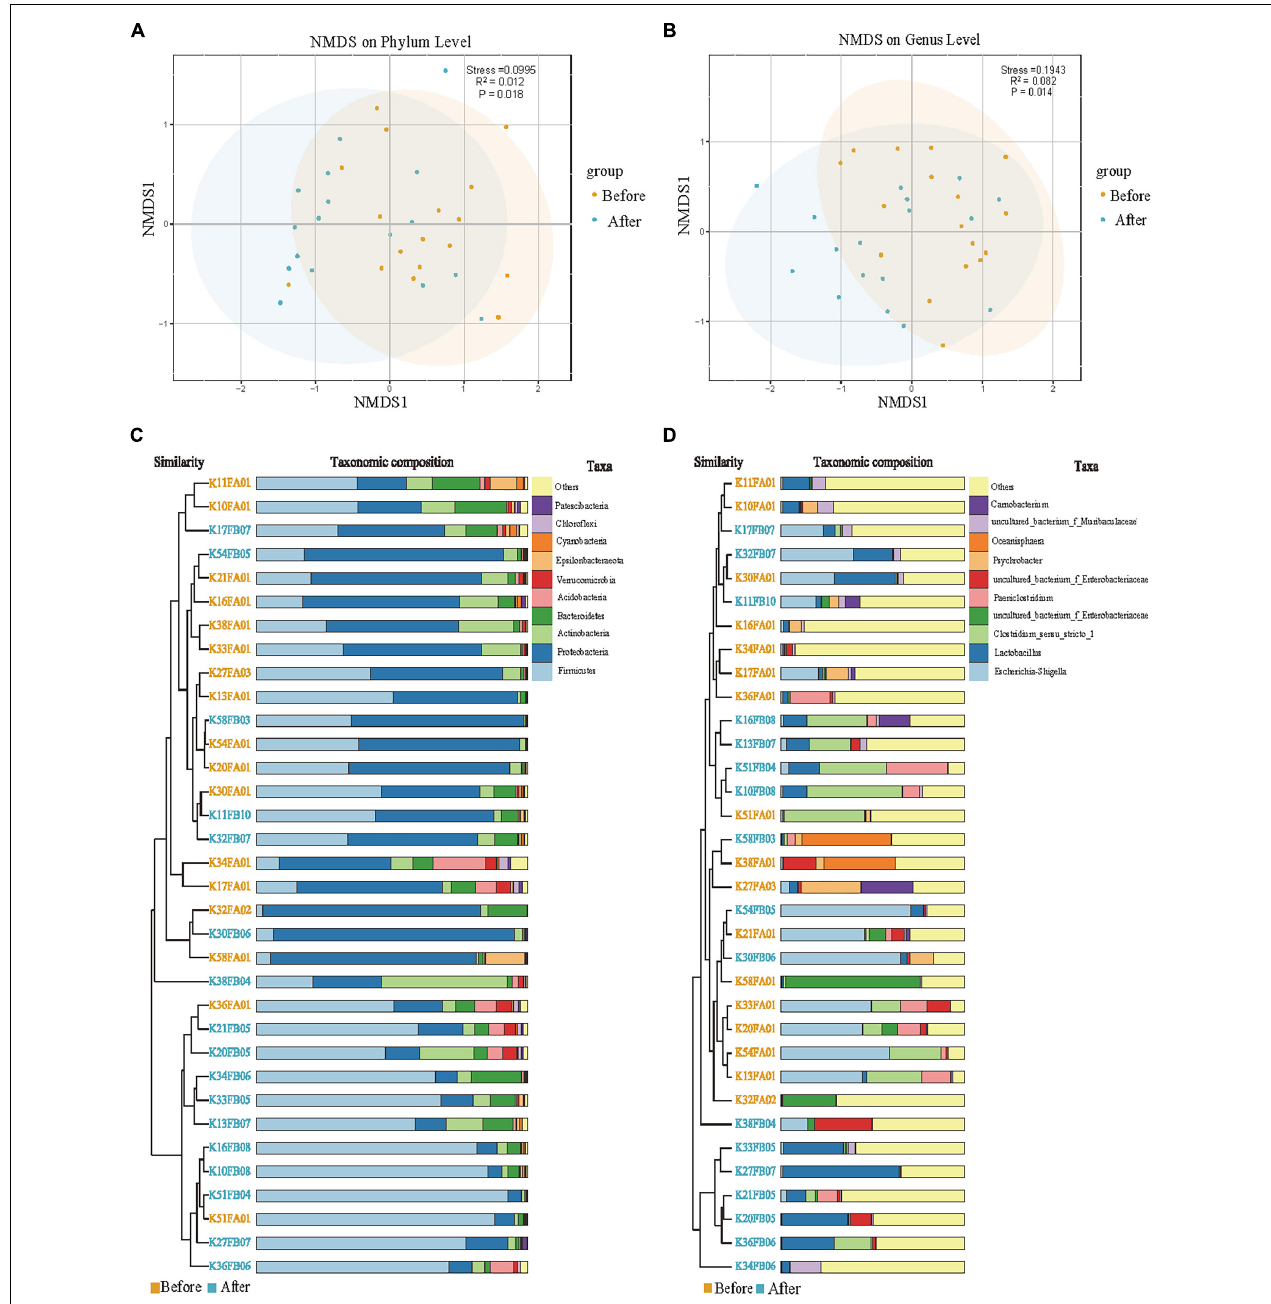
FIGURE 2 | Beta-diversity analysis of gut microorganisms between the rescued common kestrels before and after captivity. (A,B) NMDS analyses based on weighted UniFrac distances at phylum and genus levels, respectively. (C,D) UPGMA clustering at phylum and genus levels,